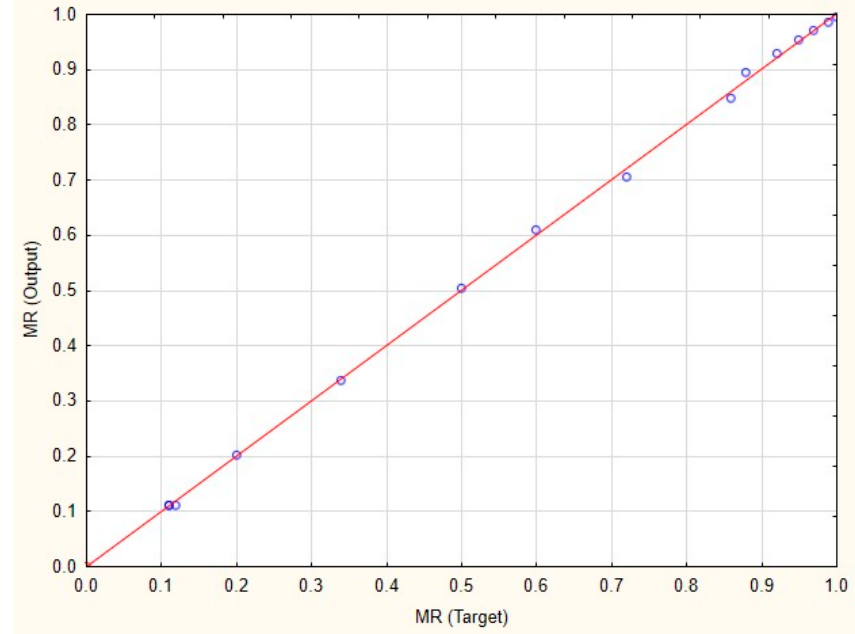
Figure 5. Fitting of ANN-2 to experimental data.